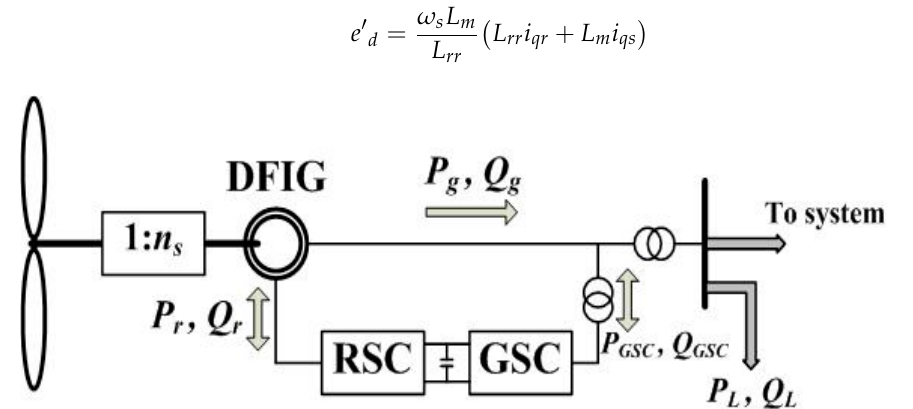
Figure 2. Connection diagram of a wind farm with a DFIG to the system.